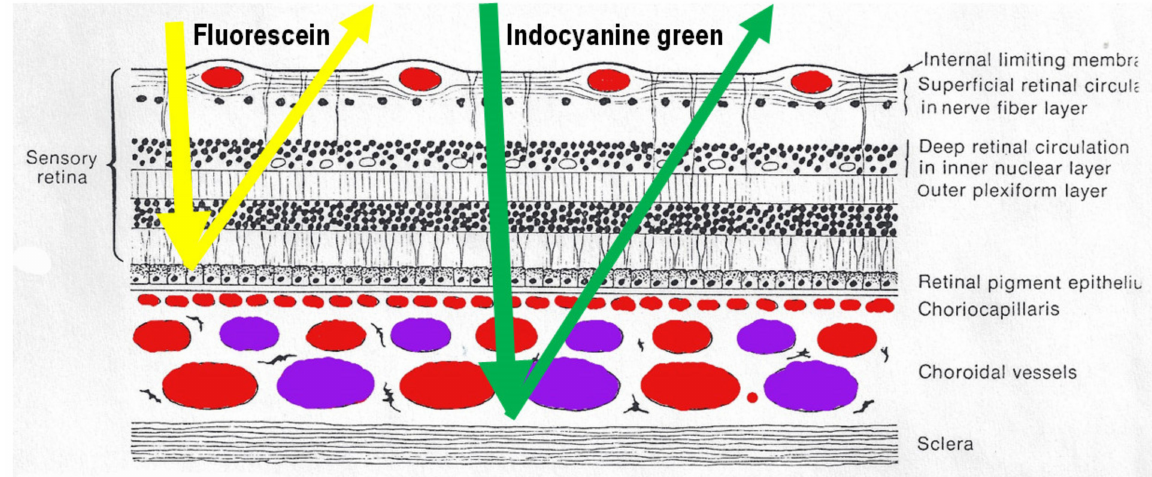
Figure 1. Difference between fluorescein (FA) and indocyanine green angiography (ICGA). FA is only able to analyse the fluorescence coming from the retina as the retinal pigmentary epithelium is blocking visible light fluorescence (yellow arrow), while ICGA is able to analyse retinal and choroidal near-infrared fluorescence (green arrow).